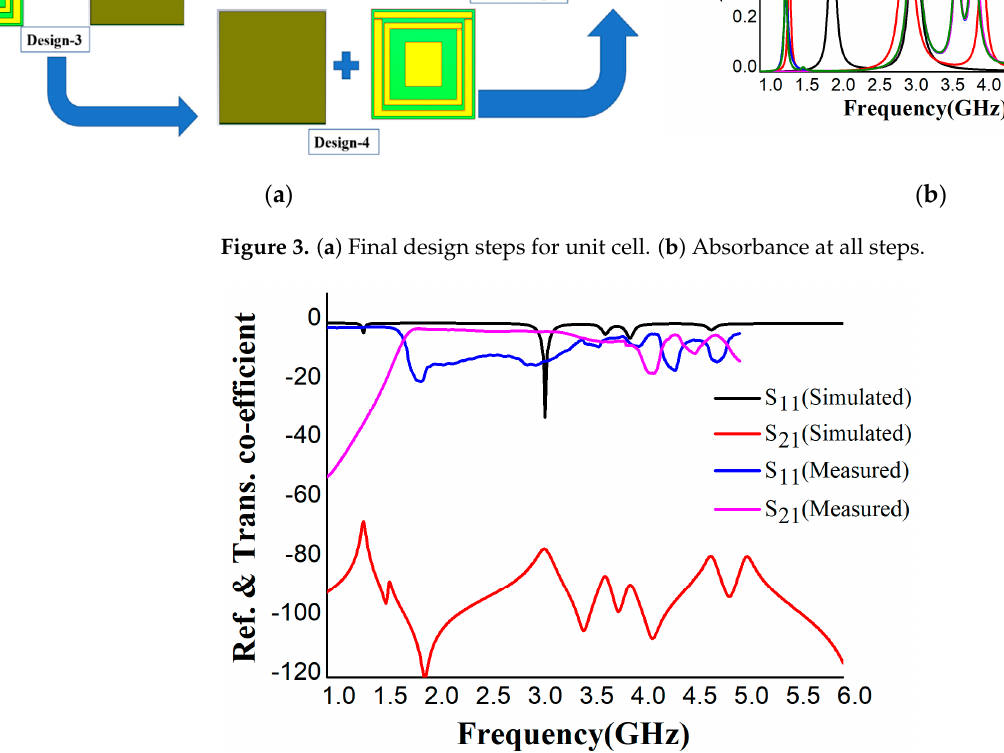
Figure 4. Reflection (S 11 ) and transmission (S 21 ) co-efficient performance at the dB scale.